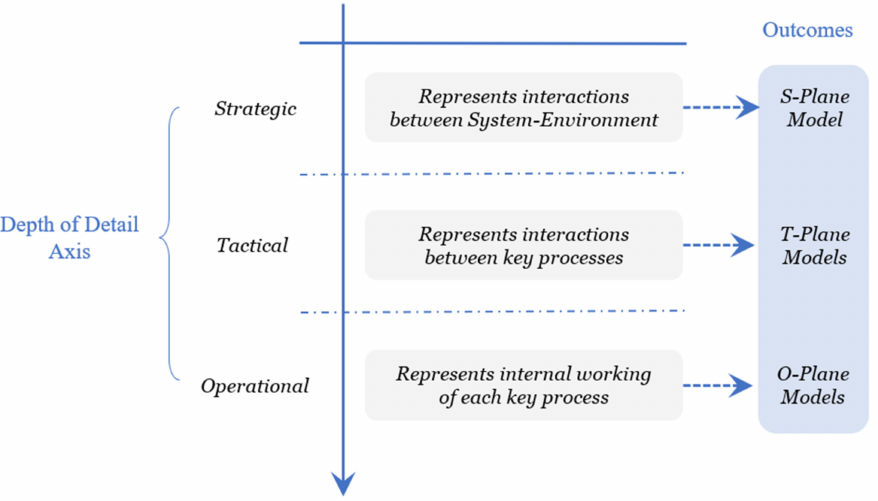
Figure 5. Modelling Abstraction levels. Each levels representing a trade-off between scope and span.